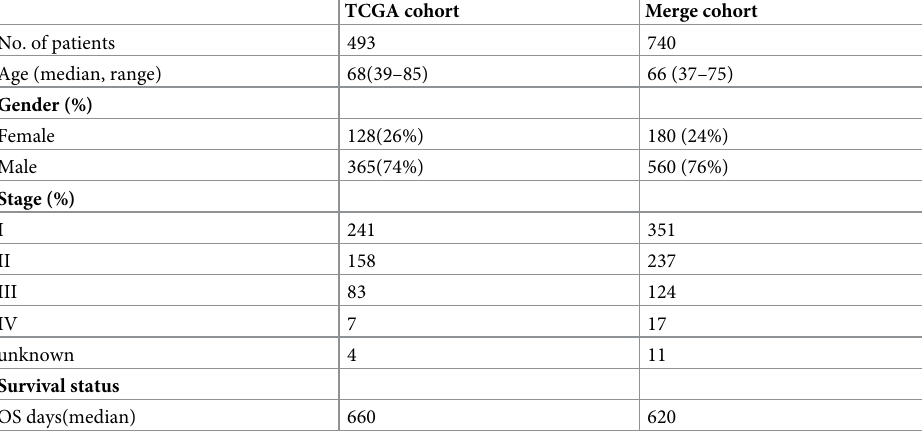
Table 1. Clinical characteristics of the LUSC patients used in this